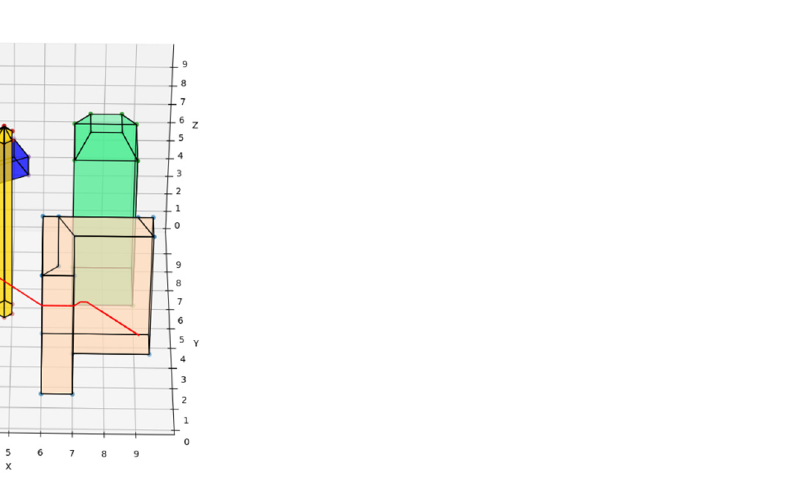
Figure 11. UAV route deploying traditional A* route planning algorithms in disturbance scenarios.